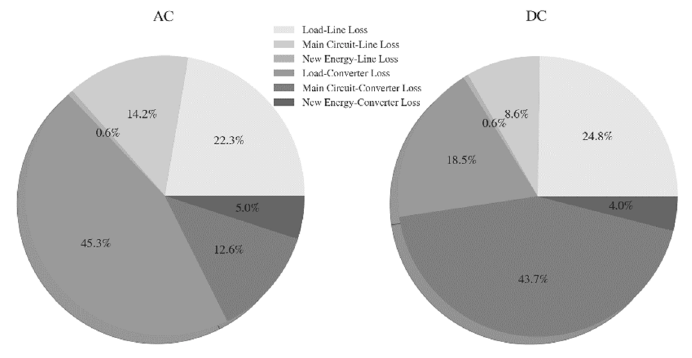
Figure 7. Composition analysis of energy loss for AC and DC systems.